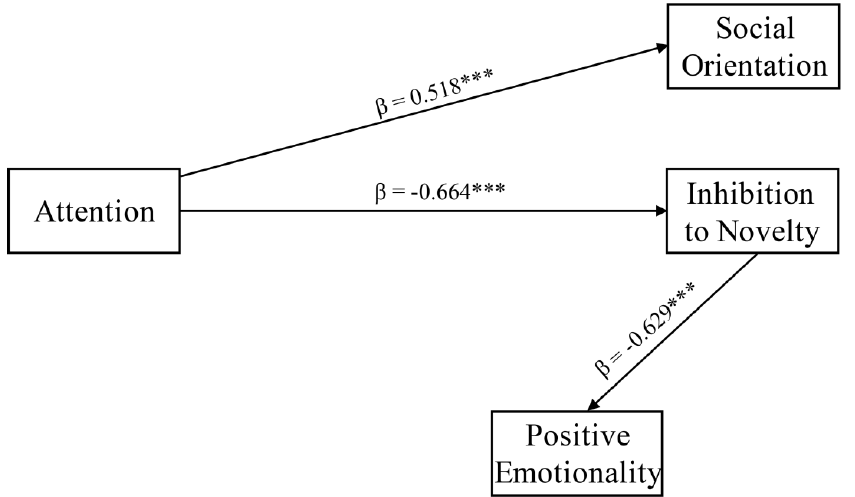
Figure 2. Path analytic model related to QUIT subscales for Mindfulness sample post-intervention ( n = 23). *** indicates p < 0.001. ( n = 23). *** indicates p <